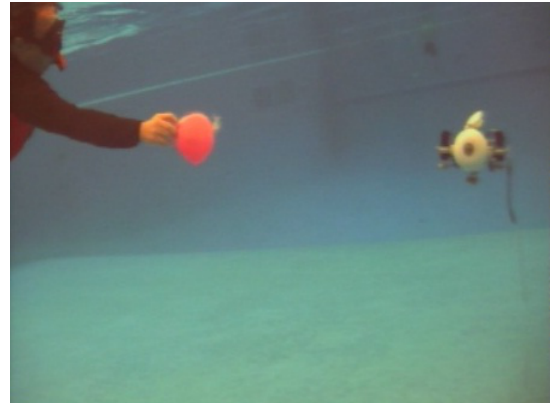
Figure 8. Ball following test into the swimming